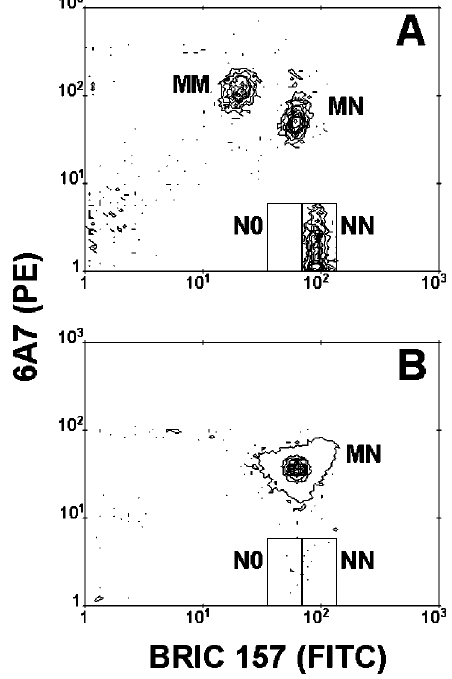
Fig. 1. Bivariate FCM distribution of a mixture at equal ratios of fixed erythrocytes obtained from MM, NN and MN donors (A) and from a MN control healthy donor (B). The rectangular areas denoted by N0 and NN contain the corresponding GPA variant erythrocytes. The assay was performed by direct immunofluorescence labelling with specific monoclonal antibodies BRIC157 and 6A7. N0 and NN variant erythrocytes from a MN individual is shown in Fig. 1(B) over 1 million cells. Variant